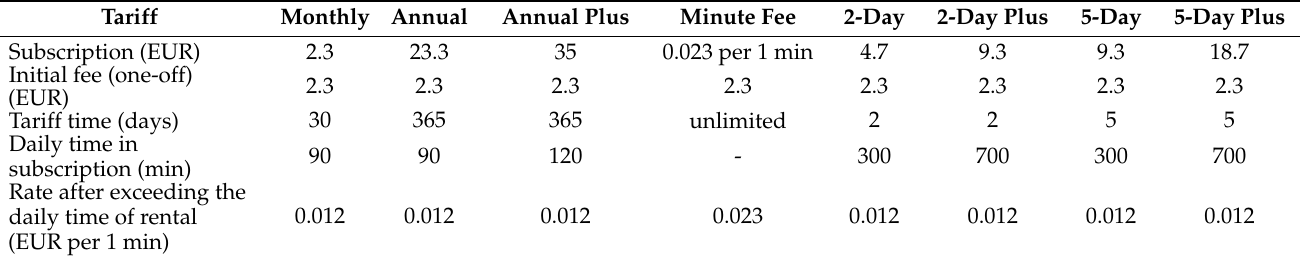
Table 6. Prices of particular tariffs of the MEVO system.